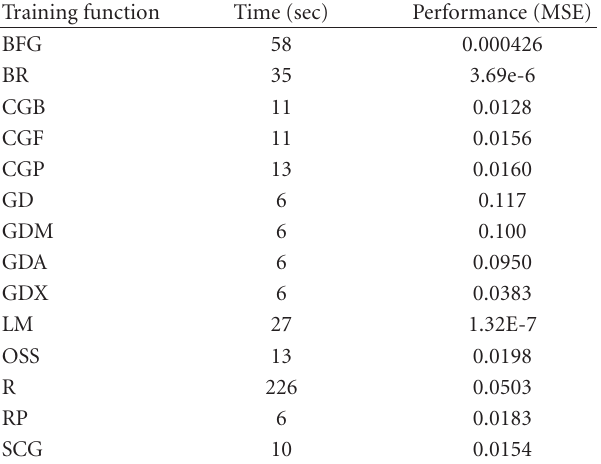
Table 2: Evaluation of the e ff ect of di ff erent training algorithms on the performance of multilayer feedforward NN with 144-70-1